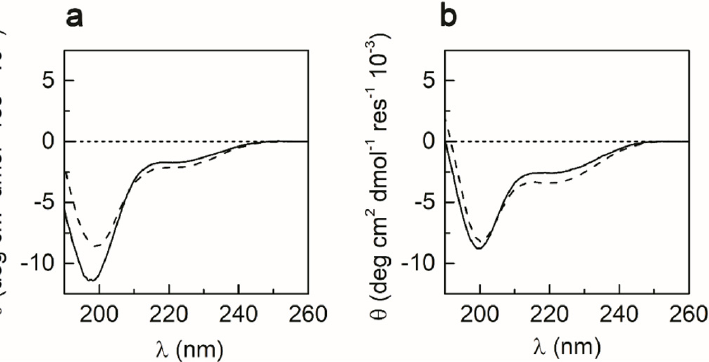
Figure 4. Far-UV CD spectra at 0.2 mM peptide concentration of fully reduced METP3 (solid lines) and Zn(II)-METP3 complex (dashed lines) in: ( a ) H 2 O at pH 7.5 or ( b )